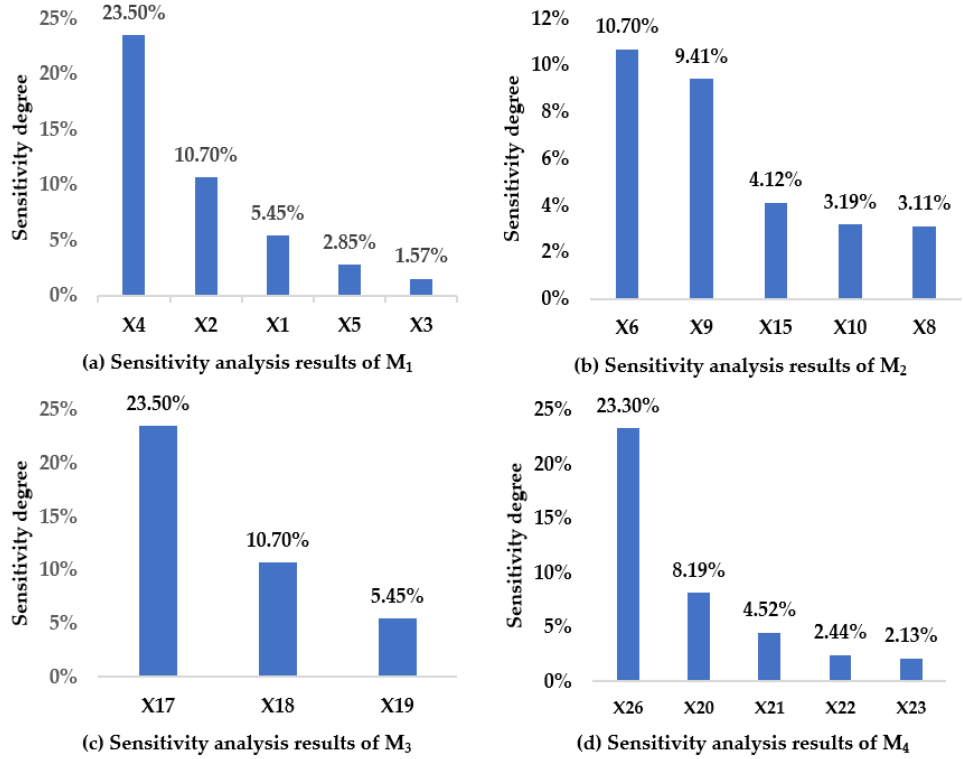
Figure 8. Sensitivity analysis results.